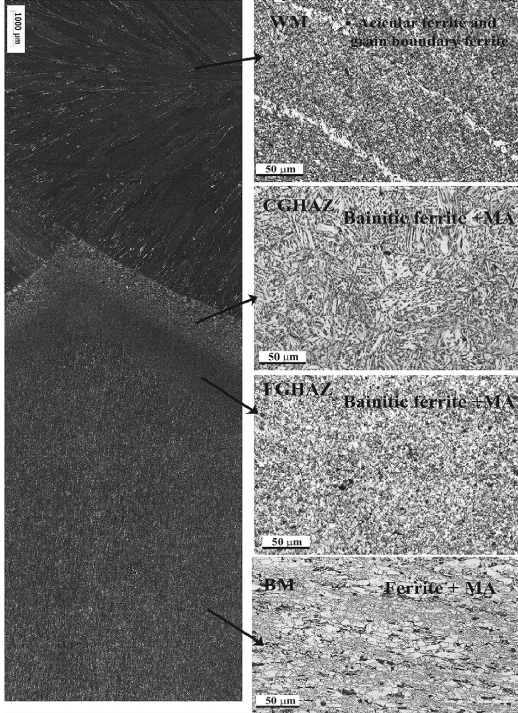
Figure 11. Optical microscopy characterization of localized attacks suffered by different microstructures on the welded joint surfaces after the electrochemical